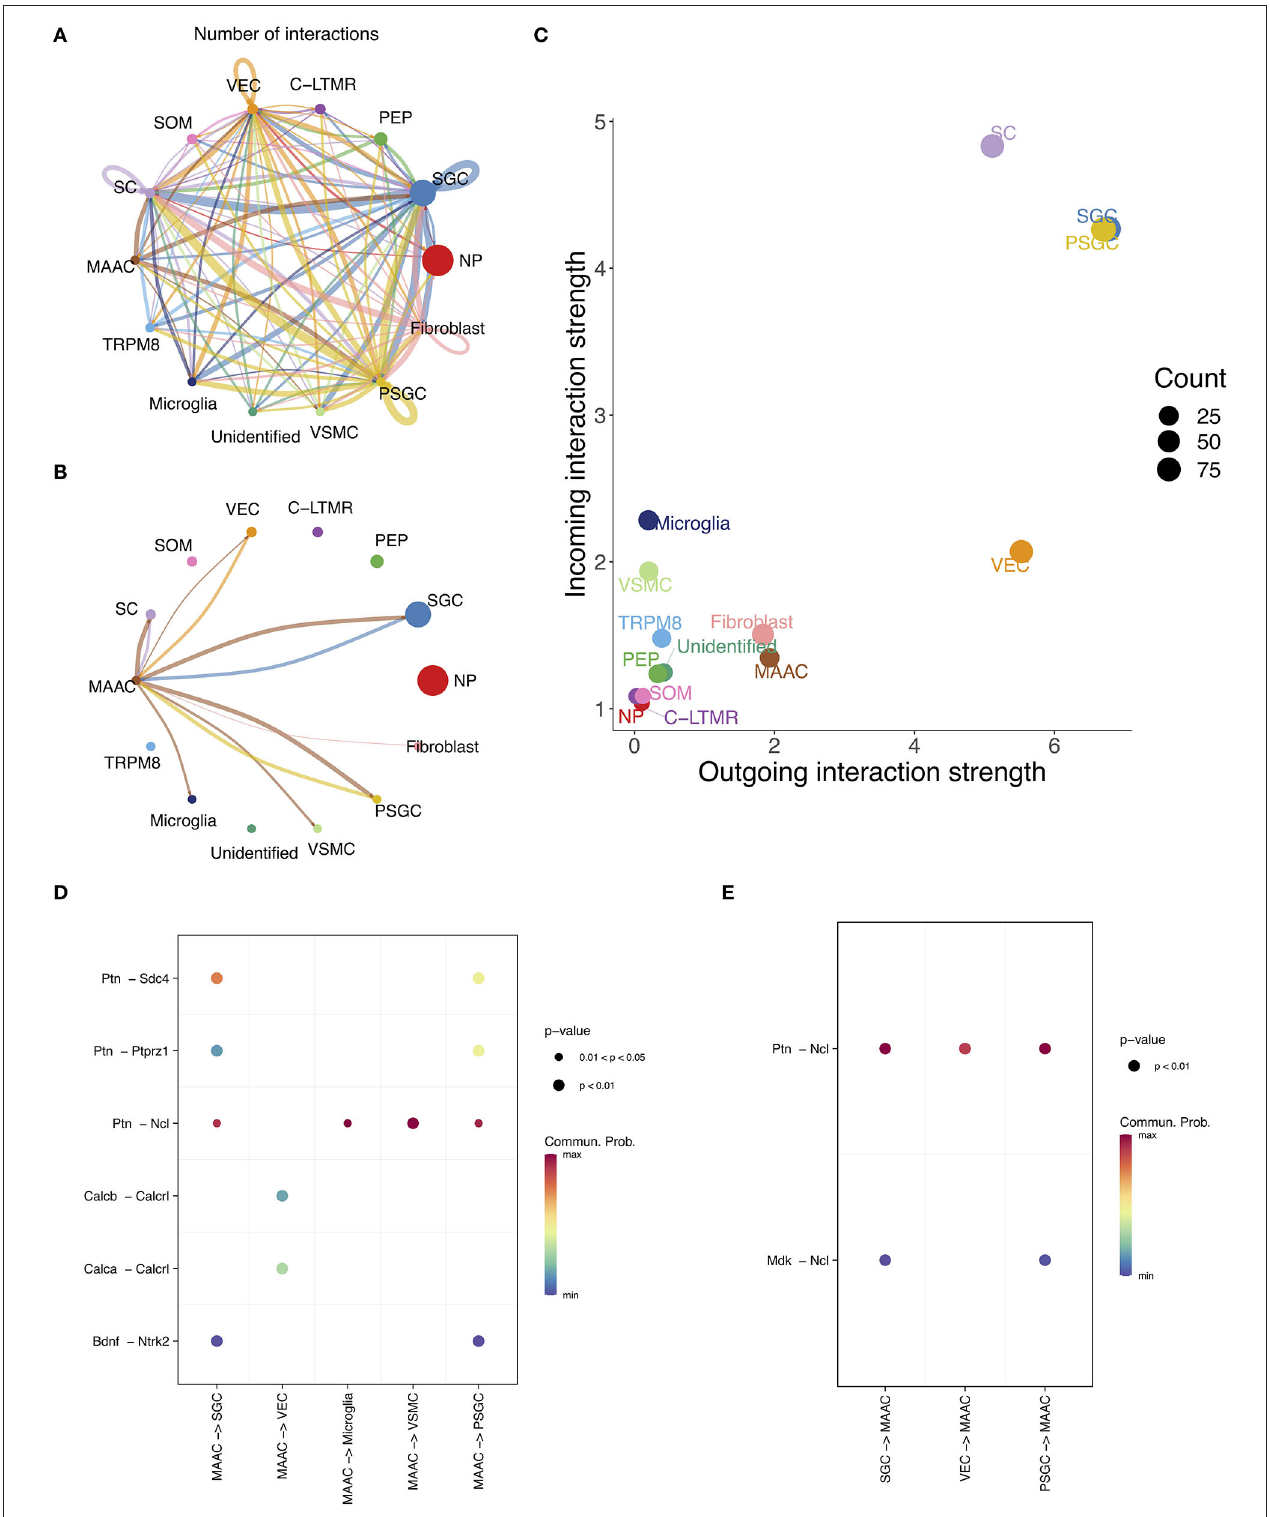
FIGURE 5 | The intercellular communication of MAAC. (A) Intercellular communication network reflects the number of interactions between clusters. Nodes, neuronal clusters; node size, cell counts; edge width, number of interactions. (B) Intercellular communication network shows the number of interactions between MAAC